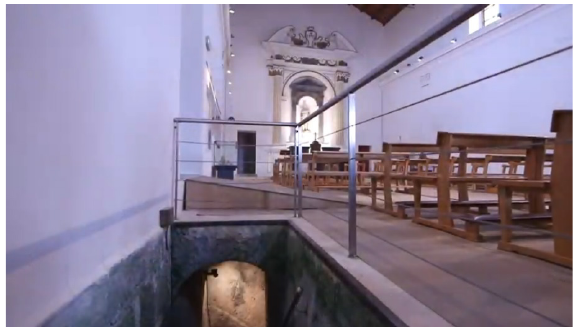
Figure 5. Southern entrance in the Saint John Church.